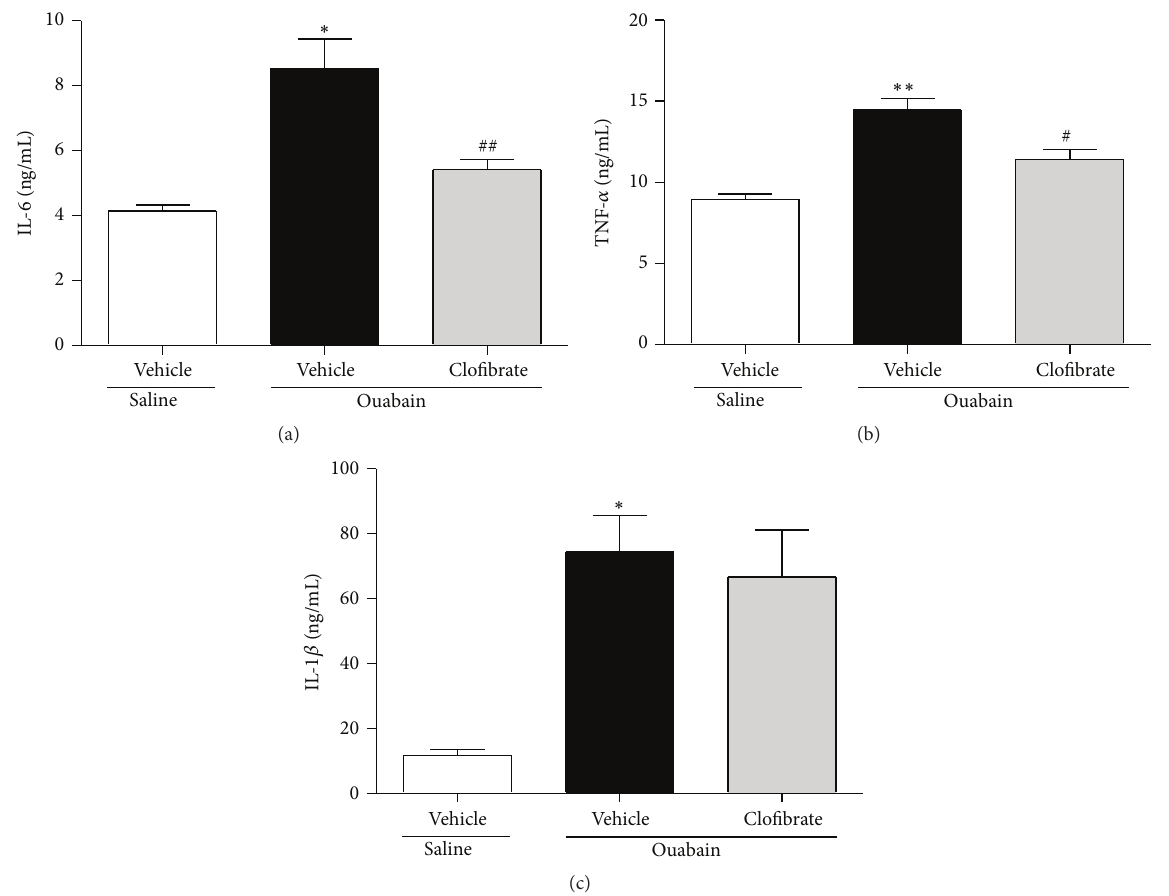
Figure 5: Atrial levels of IL-6 (a), TNF- 𝛼 (b), and IL-1 𝛽 (c) in saline- and ouabain-injected vehicle- and clofibrate-treated groups. Data are shown as mean ± SEM. Four rats were used in each group. ∗ 𝑃 ≤ 0.01 and ∗∗ 𝑃 ≤ 0.001 compared to saline-injected vehicle-treated group; # 𝑃 ≤ 0.05 and ## 𝑃 ≤ 0.01 compared to ouabain-injected vehicle-treated